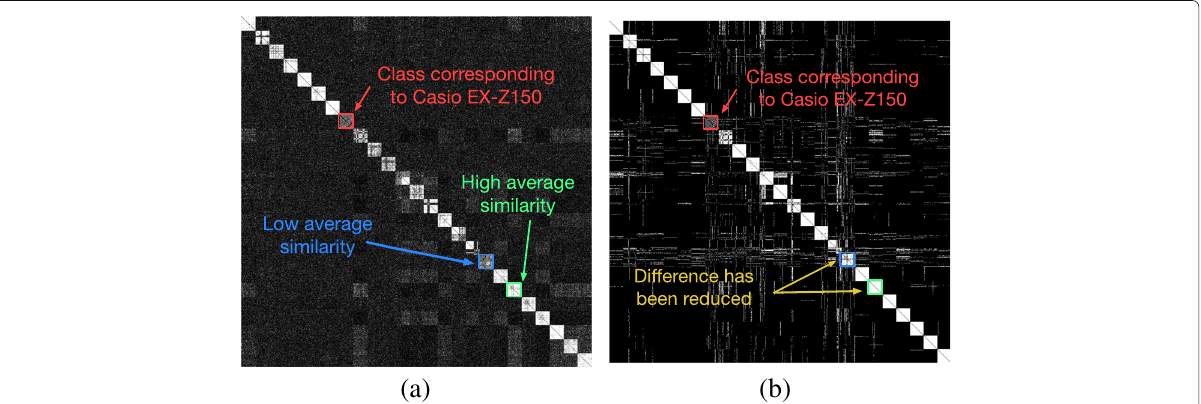
Fig. 1 Pairwise similarities of 1000 images taken by 25 cameras (each responsible for 40 images). a Correlation matrix ρ . b Similarity matrix W in terms of shared κ -nearest neighbor ( κ =